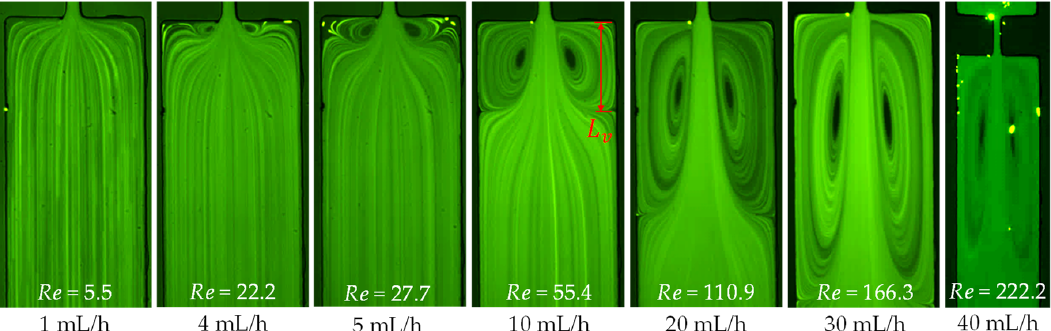
Figure 3. Inertial flow (downward) behavior of Newtonian water at the expansion part of the microchannel in a range of flow rates. No circulations are formed at the contraction part in any of the tested flow rates. The scale bars each represent 100 µm.